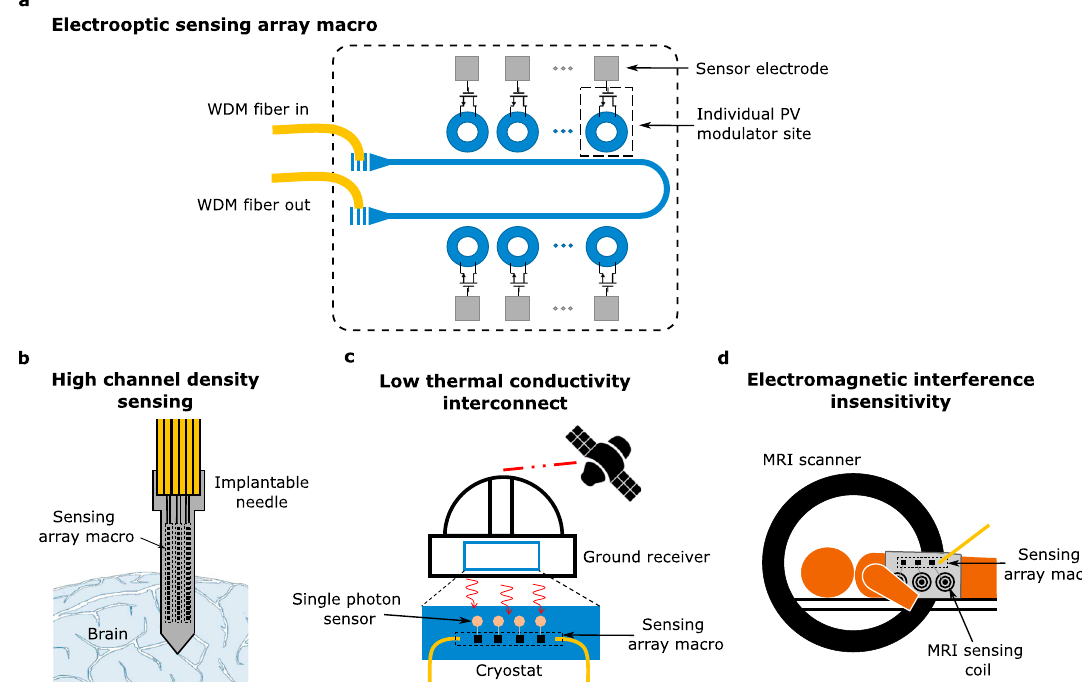
Fig. 1 Ef fi cient optical readout in sensing applications. a Schematic of a low-power electro-optic transducer based on our photovoltaic (PV) modulator. Individual PV modulators connected to different sensing sites are addressed using different wavelengths through a wavelength division multiplexing (WDM) scheme. The development of such a compact, low-energy electro-optical transducer is essential for sensing applications where the electrical energy at the sensing site is constrained. Examples include massively parallel readout of electrophysiological signals ( b ), readout of single-photon sensors operating at cryogenic temperatures ( c ), and readout of electrical signals in environments with high electromagnetic interference, such as in magnetic resonance imaging (MRI) ( d